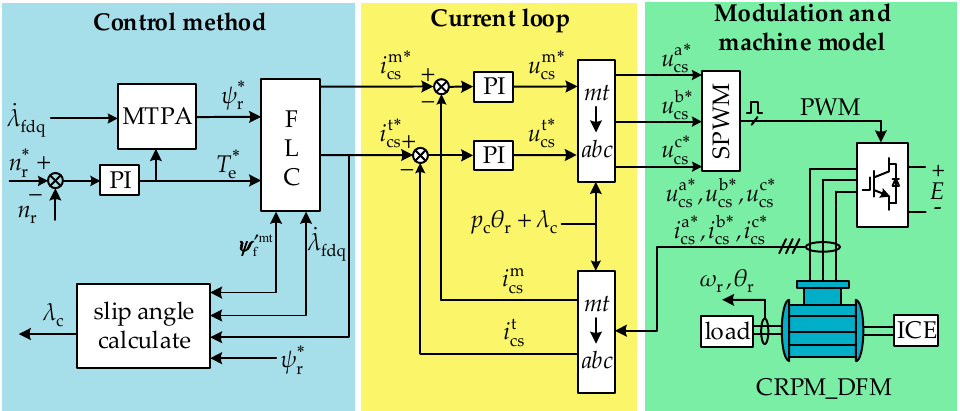
Figure 9. The control block diagram of CRPM-DFM.